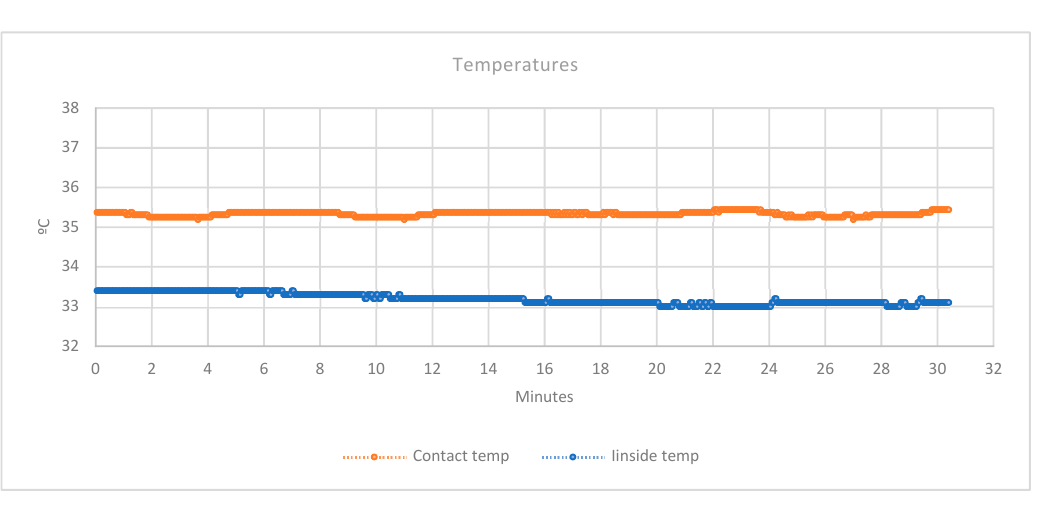
( c ) Figure 10. Example of the serial data collection using the Arduino board ( a ), real splint prototype with electrical wiring mounted over the arm ( b ) and detailed view of the closing buttons ( c ). 3.2.1. Temperatures In Figure 11, the mean temperature of the two sensors in contact with the skin is shown in orange. The temperature inside the splint is shown in blue. It is possible to see that the sensors in contact with the skin, registered a temperature slightly lower than the normal temperature of a person (36 °C). This fact, is produced because part of the surface of the sensors, is not in real contact with the skin. Due to this, it appears a gradient of temperature between the body and the environment. However, the distance between the skin and